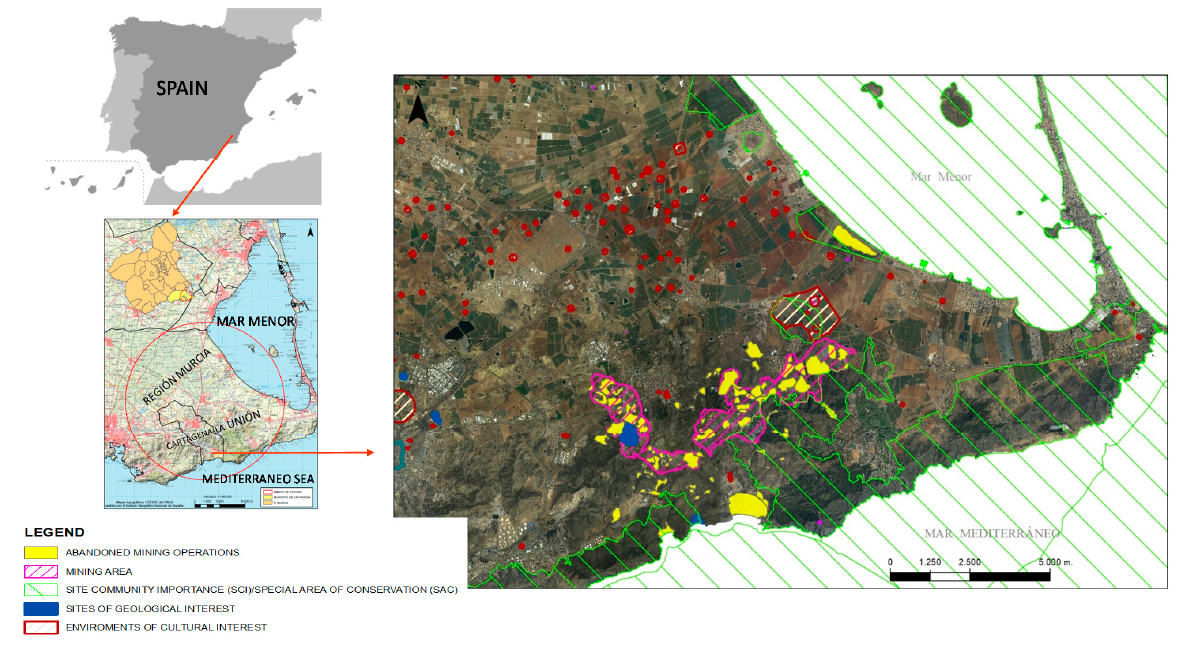
Figure 4. Location and characteristics of the study area.